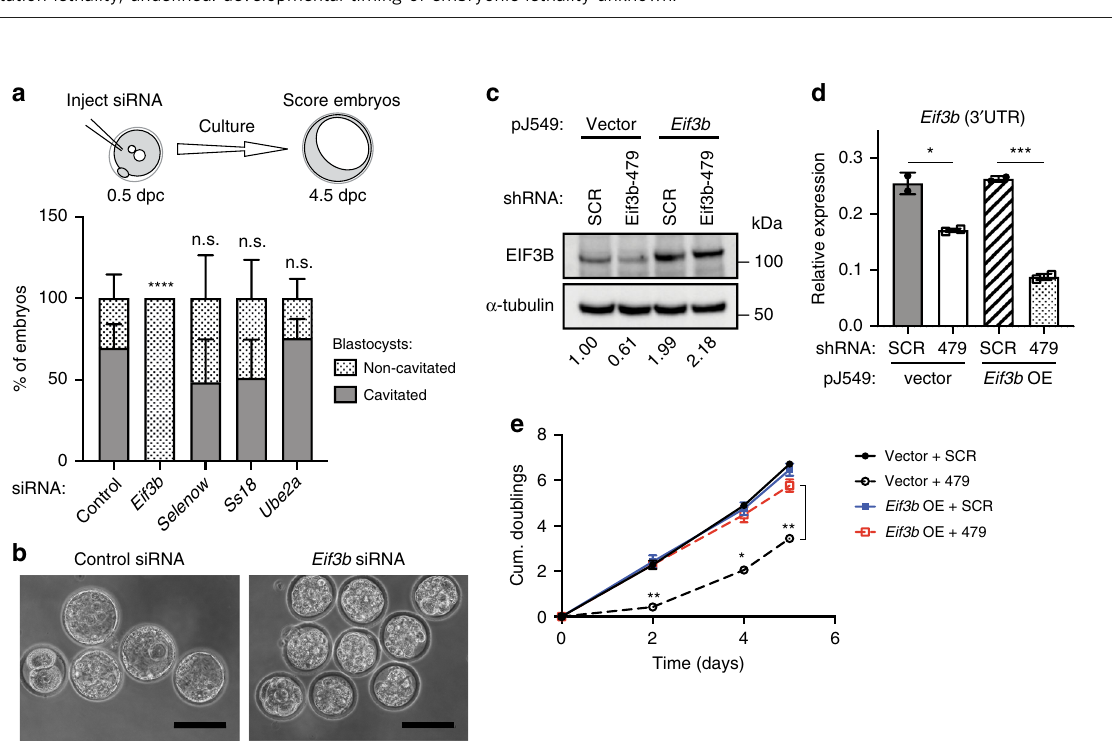
Fig. 3 PRDM10 binding is associated with transcriptional activation of target genes. a Volcano plots of RNA-seq data from Prdm10 Δ / Δ vs. Prdm10 F/F mESCs at indicated time-points post-deletion, with P adj < 0.05, fold-change (FC) > 2 used as the cut off to de fi ne genes with signi fi cant changes in expression. Red: genes directly bound by PRDM10; green: genes not bound by PRDM10 ( left panels ). Of these genes, PRDM10 targets are predominantly downregulated ( right ). b Volcano plot of RNA-seq data from Prdm10 Δ / Δ (KO) vs. Prdm10 + / + and Prdm10 Δ / + (CTL) 8-cell stage embryos ( left ). 28 genes bound by PRDM10 showed signi fi cant expression changes ( P adj < 0.05, fold-change> 2); of these, all were downregulated in Prdm10 -null embryos ( right ). c Venn diagram depicting the overlap of bound and downregulated genes in RNA-seq datasets for embryos (8-cell) and mESCs (Day 2 and/or Day 4 post- induction), with a total of 18 genes identi fi ed as top candidates. d Heatmap showing all 18 bound and downregulated genes from Fig. 3c, categorized by their respective gene knockout phenotypes. Asterisks indicate genes directly involved in translation, Eif3b and Eef1d . Color scale: Z -score for row- normalized expression values, scaled separately for Day 2 p.i mESCs, Day 4 p.i mESCs, and embryos. Pre-implant: preimplantation lethality; post-implant: